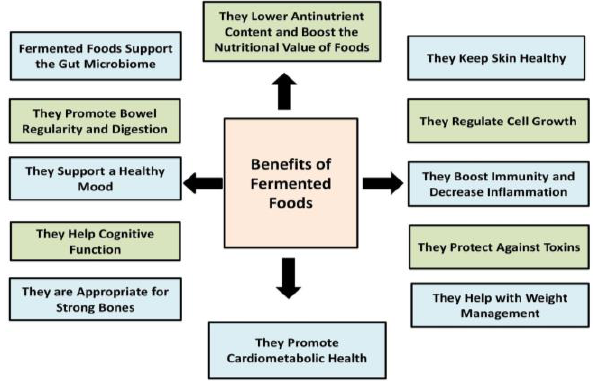
Figure 1. The most notable health benefits of fermented